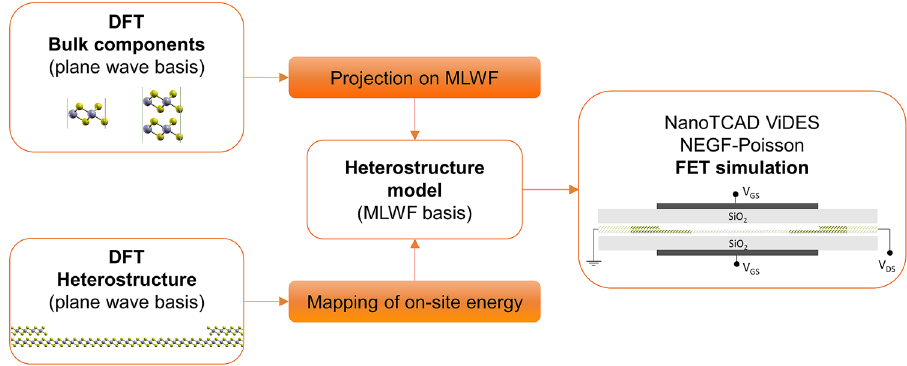
Figure 1. Block diagram of the multi-scale procedure. Bulk DFT calculations of the materials forming the LH are performed using a plane wave basis. The resulting Hamiltonians are then projected onto MLWF and used as building blocks to construct a LH Hamiltonian with an arbitrarily long channel. Then a model of the LH is simulated with DFT and the on-site energy profile, E on-site , in the direction normal to the interface is extracted. This energy profile is directly mapped on the diagonal of the MLWF LH Hamiltonian, thus correctly capturing the DFT band alignment across the LH and the electrostatic effects due to charge redistribution around lateral vmd/ vmd-1. 9.1].